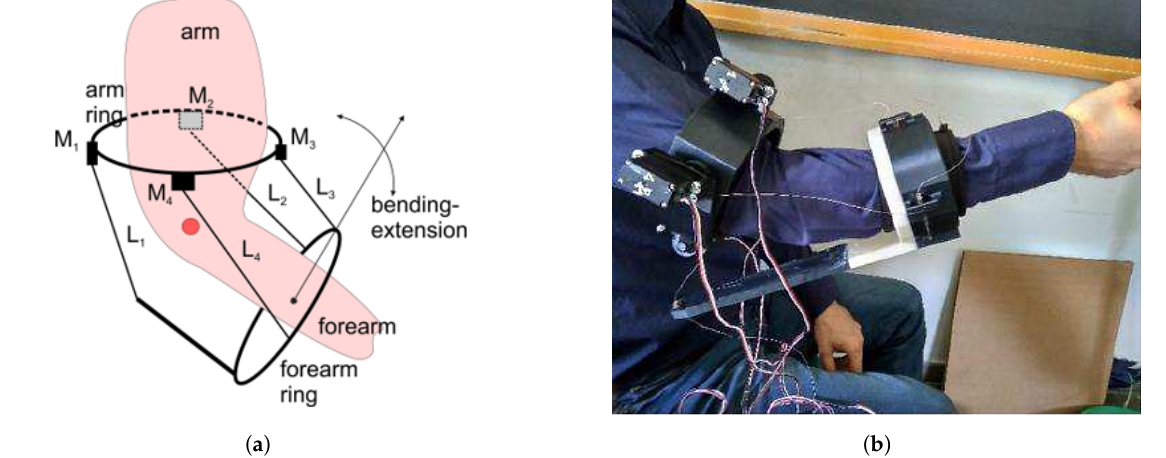
Figure 3. CADEL first prototype: ( a ) a kinematic scheme; ( b ) a lab prototype test